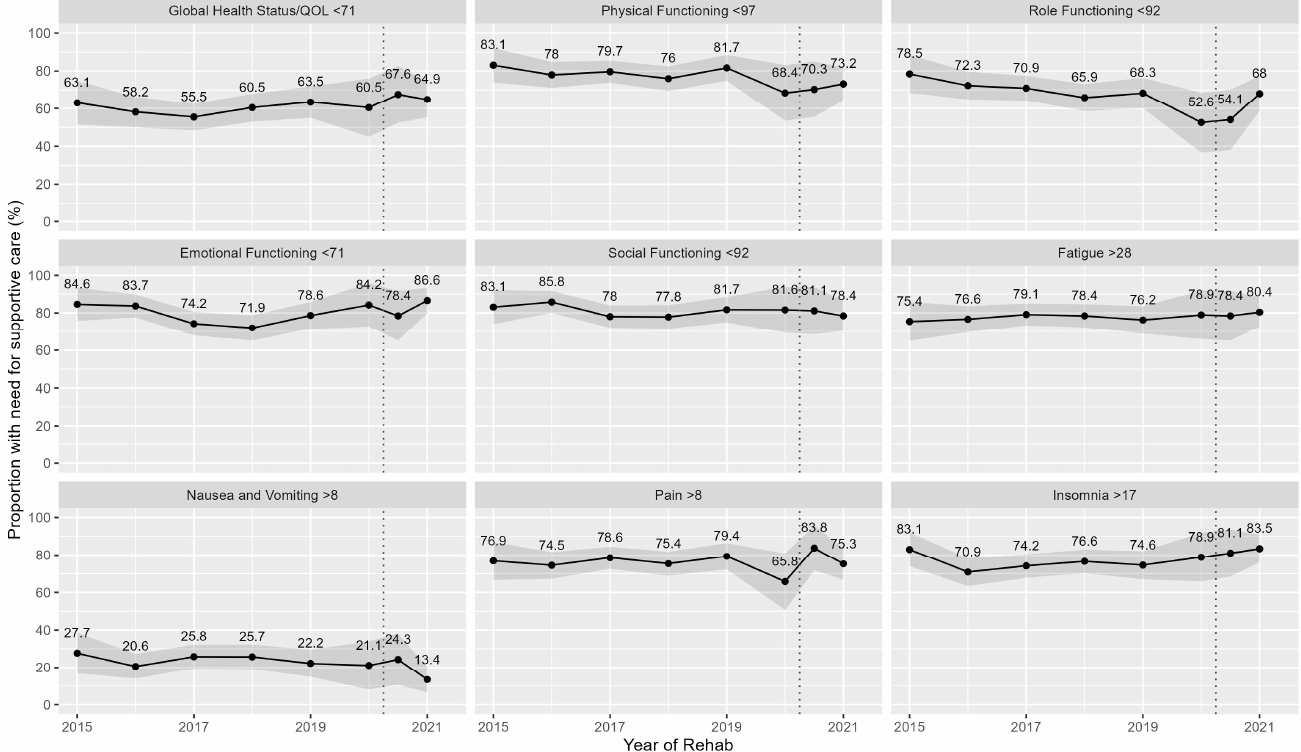
Figure 2. Proportions (and 95% confidence intervals) of young adult non-metastatic breast cancer patients with minor children participating in a 3-week inpatient mother–child rehab program with EORTC QLQ-C30 scores indicating a need for supportive care according to thresholds proposed by Lidington et al. [22] over time.